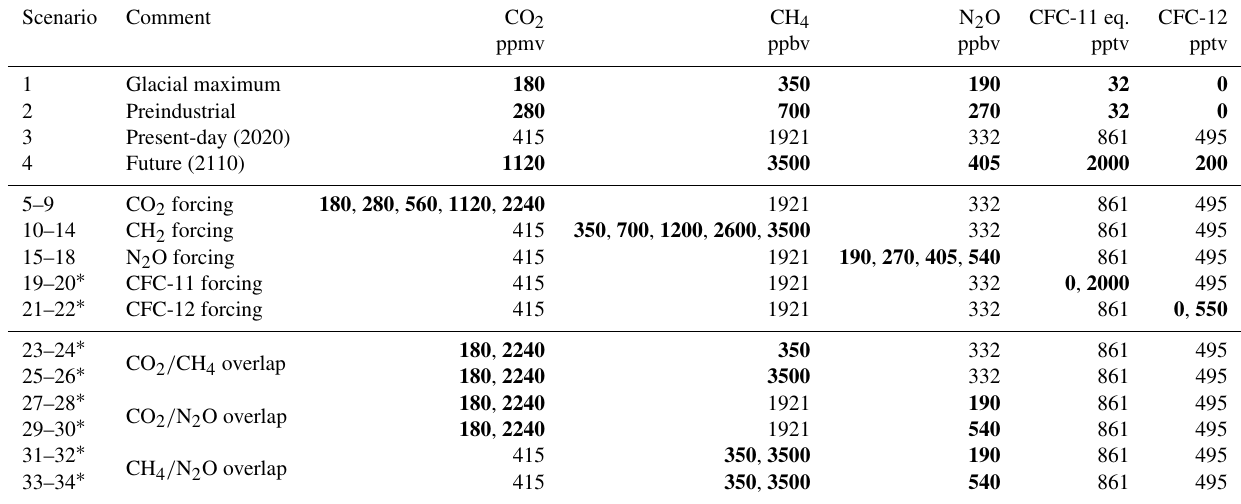
Table 2. Surface mole fractions of the five main anthropogenic greenhouse gases for the 34 scenarios considered in CKDMIP, where “CFC- 11 equivalent” is an artificially increased CFC-11 concentration to represent 38 further greenhouse gases (Meinshausen et al., 2017). The present-day scenario will be used to test CKD models developed for the two NWP applications in Table 1, while all scenarios will be used to test CKD models for climate. Scenarios 1–18 are used for both the longwave and shortwave evaluation, while scenarios 19–34 (marked with an asterisk) are used for the longwave only. Numbers in bold have been perturbed from their present-day